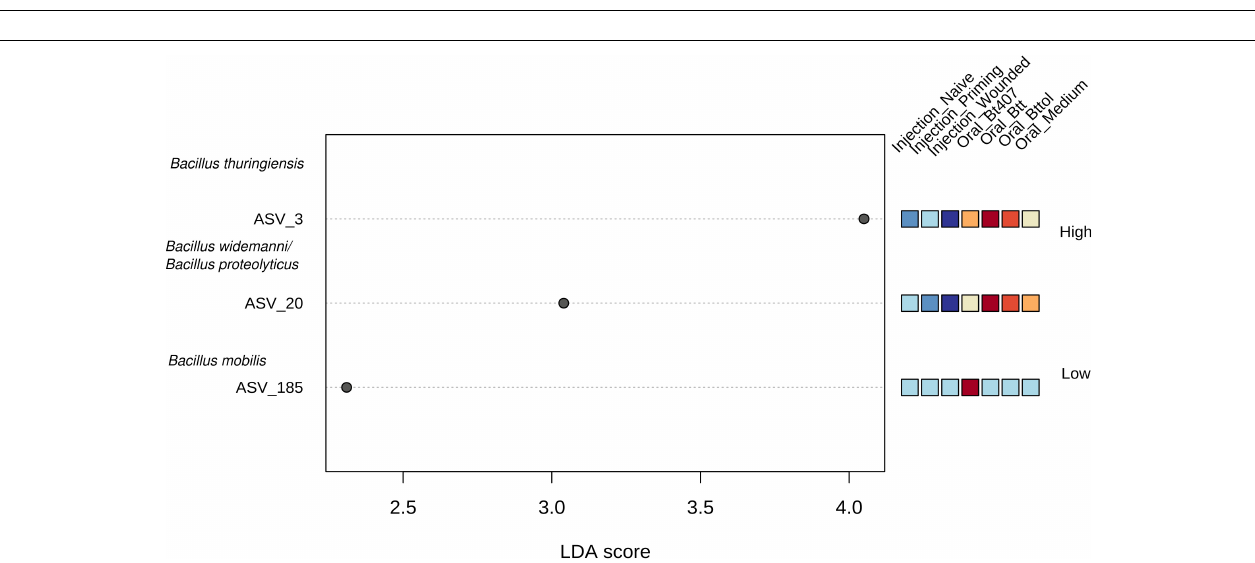
FIGURE 4 | Principal—coordinate (PCoA) plot of the first time point (24 h after priming) based on Bray—Curtis dissimilarity distances. Priming with Btt and Bt tolworthi have an impact on the microbiome composition. Ellipses are drawn around samples belonging to the same priming regime and there are six replicates of each of the regimes. Permanova: F = 2.179, R 2 = 0.284, p < 0.001. Perdmadisp: F = 2.170, p = 0.071.